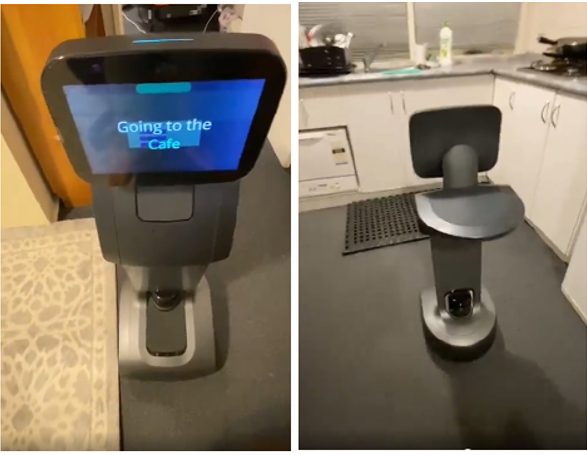
Figure 5. Robot guiding